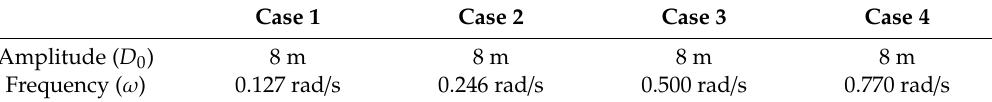
Table 2. Amplitudes and frequencies of various platform motions.